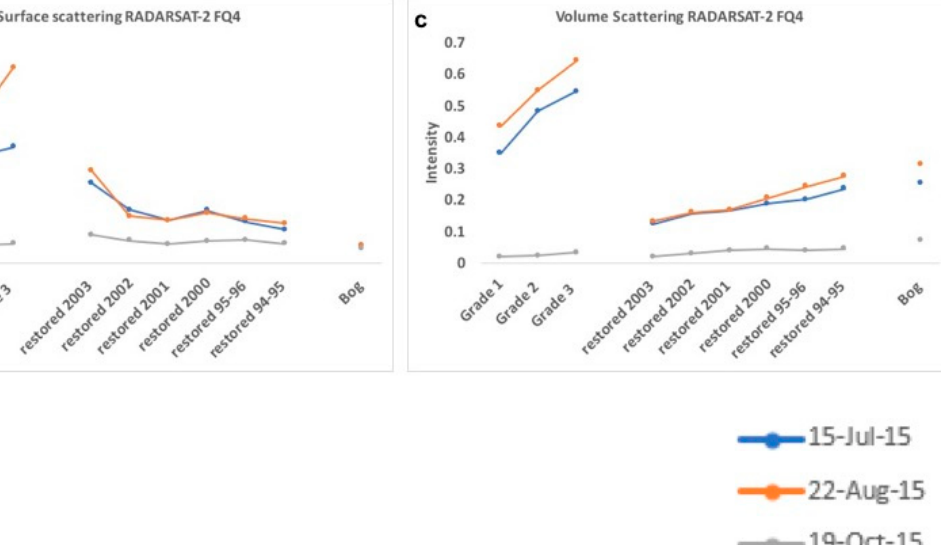
Figure 3. The Freeman–Durden decomposition spectral signatures for natural shrub bog, restored peat, and harvested peat using RADARSAT-2 FQ4 imagery. Double-bounce scattering is presented in ( a ), surface scattering in ( b ), and volume scattering in ( c ). All values are represented in decibels (dB) .